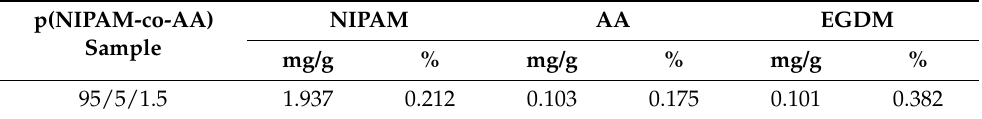
Table 2. The content of residual reactants in synthesized copolymer p(NIPAM-co-AA).